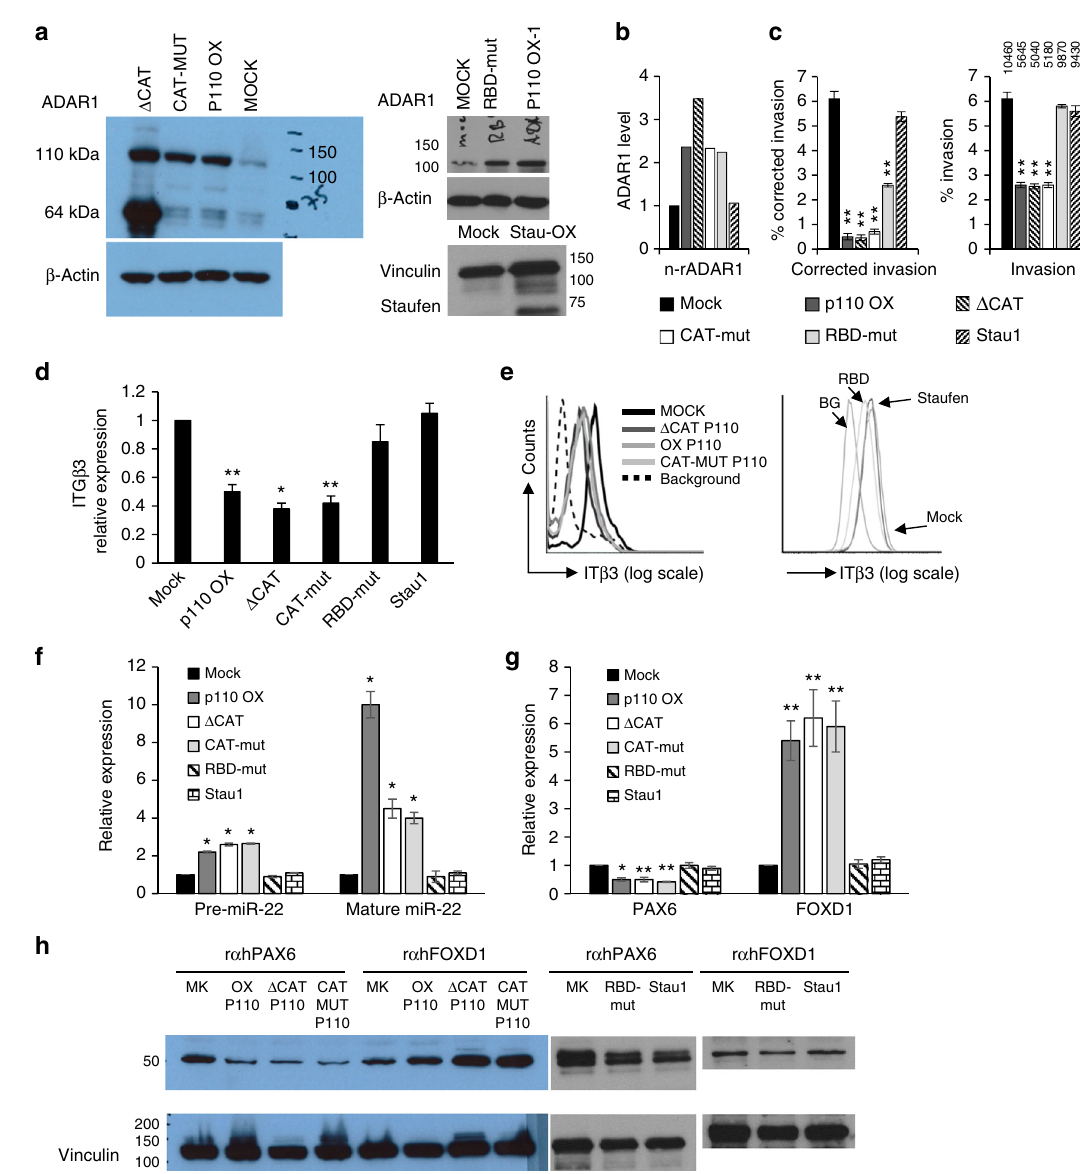
Fig. 6 ADAR1-dependent regulation of invasion is RNA-editing independent. ADAR1 constructs used for functional assays: OX-P110 (overexpression); Δ CAT-P110; CAT-MUT-P110; and ADAR1 with mutated RNA-binding domains (RBD-mut) and Staufen1 fragments ampli fi ed and cloned into pCDNA3 and transfected into 624mel cells. a Their expression, relative to MOCK (Control), was detected by western blot (ADAR1 full length is 110 kDa and lacking the catalytic domain the size is reduced to 64 kDa). β -Actin or vinculin served as controls; b ratio of normalized ADAR1 in each indicated cell line relative to Mock (n-rADAR1 stands for normalized-ratio). The various transfectants were tested for the following: c invasion rate using standardized Boyden chamber assay monitored for 24 h after seeding. Numbers above the bars represent the absolute cell count of invading cells; d ITGB3 expression was examined by qRT-PCR and e by extracellular staining with an anti-ITGB3-FITC-conjugated antibody over isotype control; f pri- and mature miR-22 expression were monitored by qRT-PCR and g , h FoxD1 and Pax6 expression were evaluated using western blot. Results of c , d and f , g represent the mean ± SE of three biologically independent experiments, each performed in triplicates. The numbers in or next to blots indicate molecular marker. Results for a , e , and h are representative of three biologically independent experiments. Asterisks represent P values: * P < 0.05; ** P < 0.01 (two-tailed t